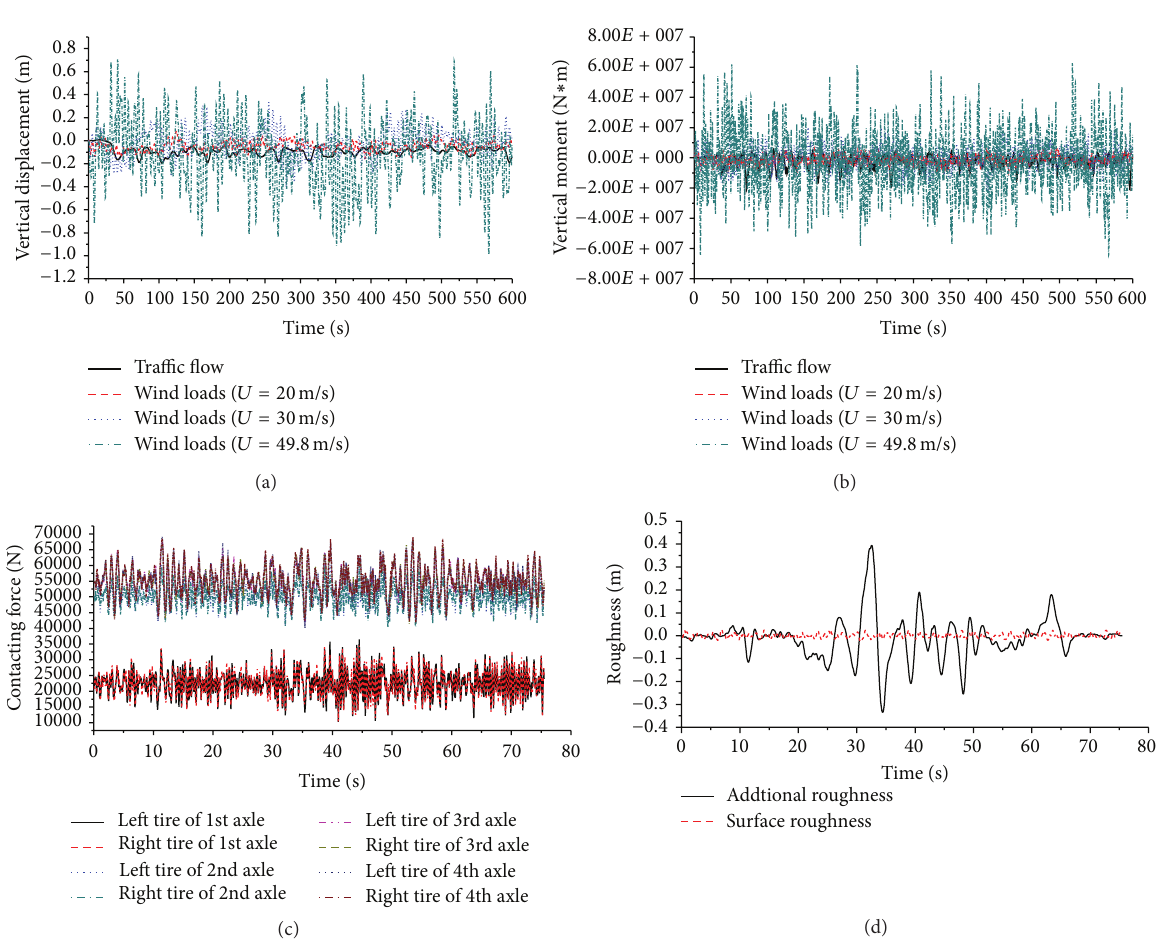
Figure 17: Time histories of responses at point C of the bridge under the action of wind loads and traffic flows: (a) vertical displacement; (b) vertical moment; (c) contacting force of a 4-axle vehicle with the bridge deck at the wind velocity of 49.8 m/s; (d) surface roughness and additional roughness at one of the contacting points of a 4-axle vehicle’s tires with the bridge